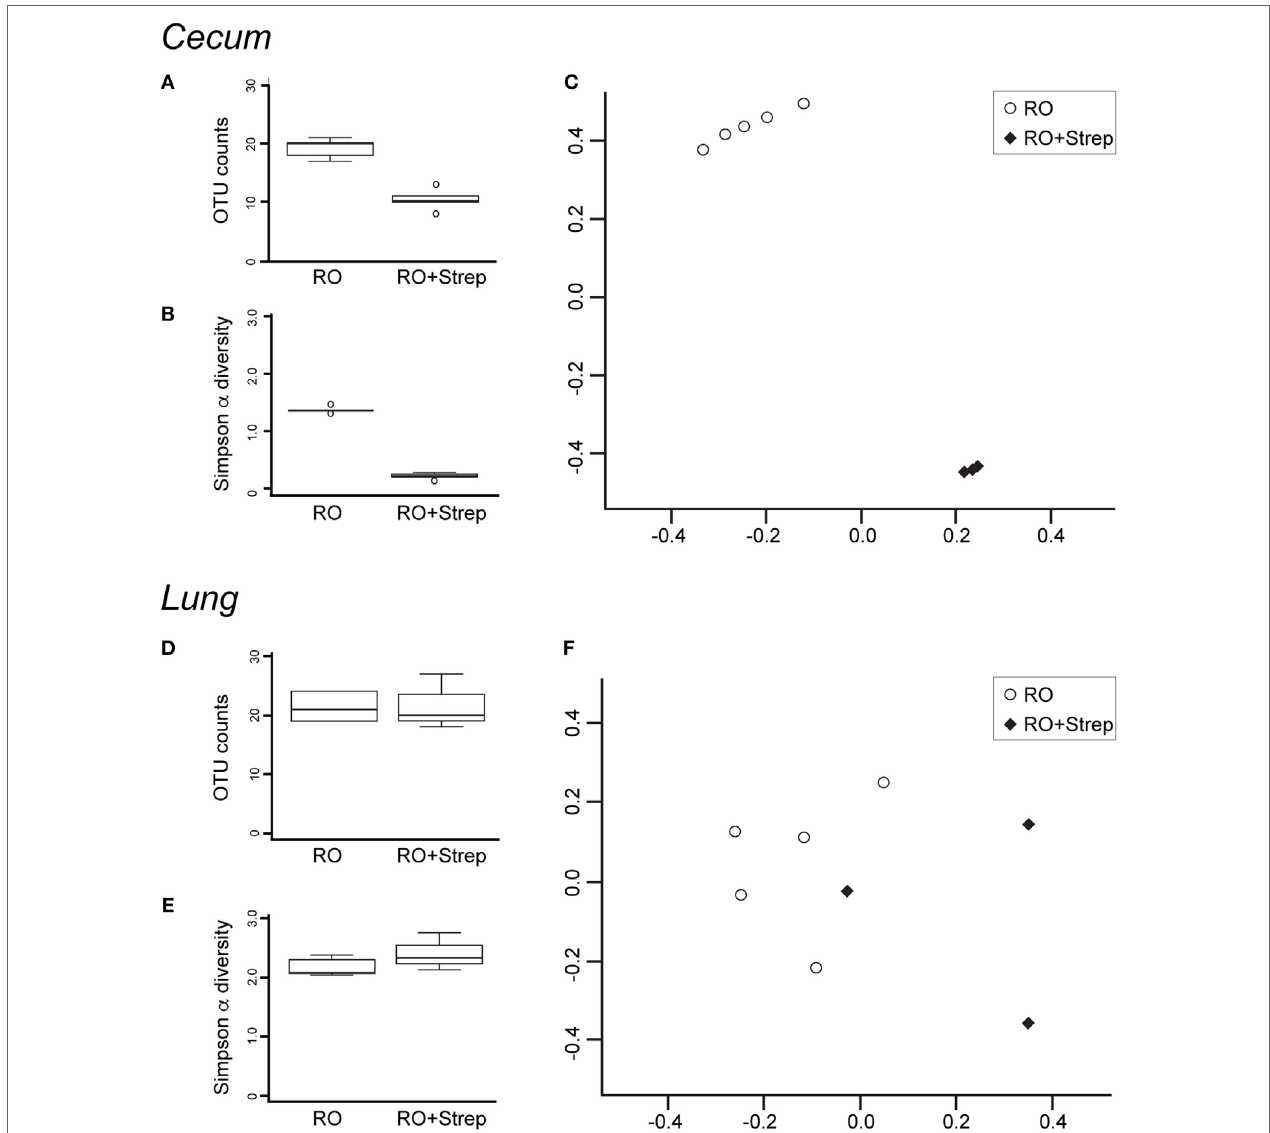
FigUre 2 | Streptomycin treatment reduces the abundance and diversity of cecal but not lung microbiota. DNA was isolated from cecum (a–c) and lung (D–F) after 2 weeks of reverse osmosis (RO) or RO + streptomycin treatment, and analyzed for microbial composition. Operational taxonomic unit (OTU) counts (a,D) and alpha diversity (B,e) were compared between treatment groups. Beta diversity was compared using Non-metric Multidimensional Scaling Ordination of the Bray–Curtis beta diversity metric (c,F) . (a) Significant differences were seen in cecal OTU count ( p = 4.5 × 10 − 5 , n = 5), (B) Simpson alpha diversity index ( p = 1.5 × 10 − 9 , n = 5), and (c) beta diversity (Adonis p = 0.012, n = 5, note that two treated samples were so close to the others that the treated group appears as only three samples). No significant differences were noted in lung microbiota (D) OTU composition, (e) Simpson alpha diversity index, or (F) beta diversity between antibiotic-treated ( n = 3) and -untreated ( n = 5)